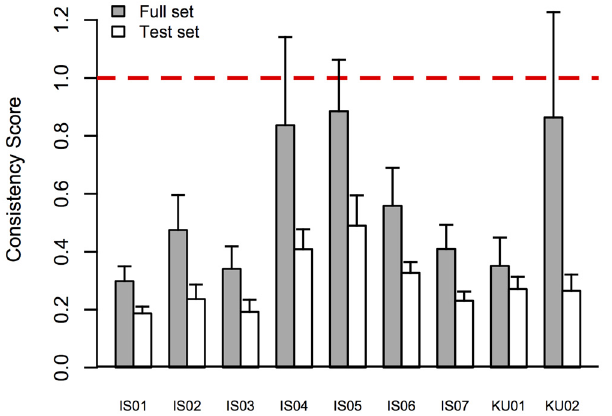
Fig 4. Consistency scores for all observers. The gray bars show the consistency for the full set of mapped graphemes (letters A – Z; digits 1 – 9). White bars show consistency scores for the 12 letters and 6 digits used in the experiment. The error bars represent +1 SEM. The red dashed line shows the inclusion criterion for participation in the experiment (see [71], Eq